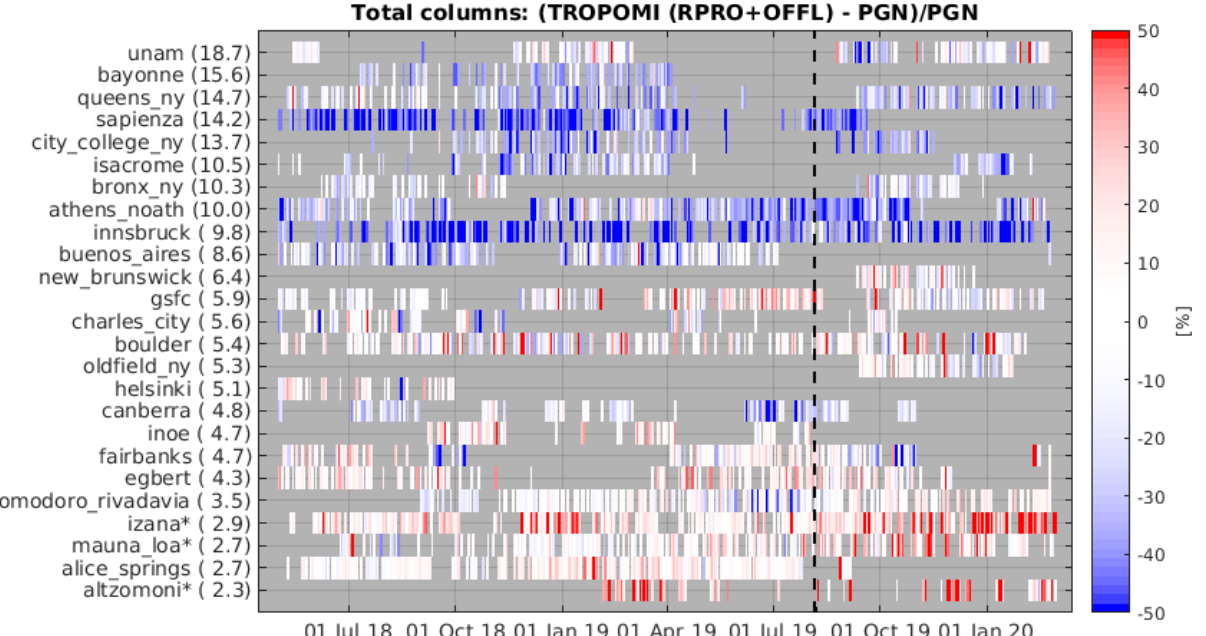
Figure 13. Percent relative difference between the S5P TROPOMI and PGN NO 2 total column data as a function of time. Stations are ordered by median NO 2 total column (lowest median value at the bottom). The dashed vertical line on 6 August 2019 represents the reduction in S5P ground pixel size from 7 . 0 × 3 . 5 to 5 . 5 × 3 . 5km. The three mountaintop sites more suited for the validation of only the stratospheric column are marked with an